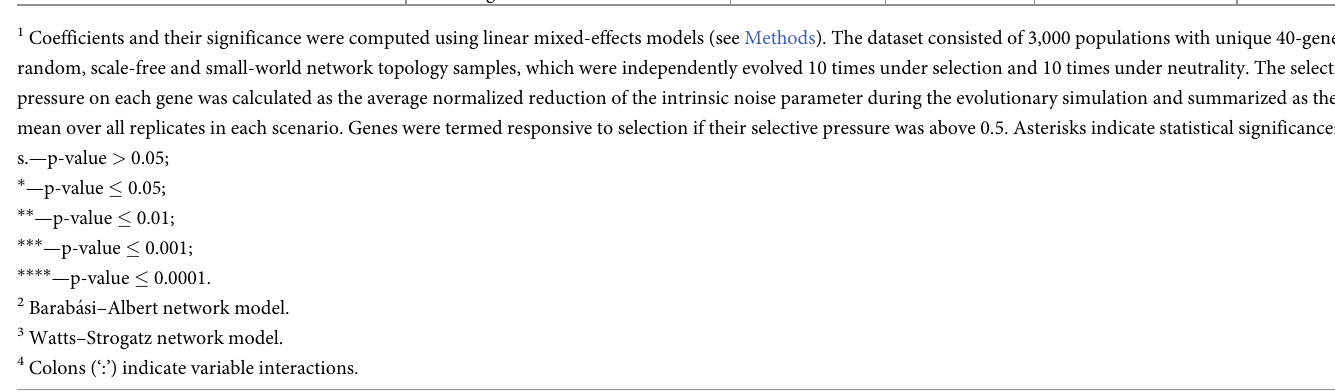
of noise through noise propagation between the genes. Specifically, networks with a lower diameter, mean path distance, indegree centralization, and higher outdegree centralization and average degree, had higher average gene expression variance. In the selected populations, the average selective pressure per network was significantly negatively affected by both syn- thetic network diameter and centralization and the synthetic average degree (linear model with synthetic network diameter and centralization coefficient β = -0.003, p-value = 4.9 × 10 − 11 , Fig 6A; synthetic average degree coefficient β = -0.009, p-value < 2.2 × 10 − 16 , Fig 6B). The mutual information was significant between the average selective pressure per network and synthetic network diameter and centralization (MI = 0.27, p-value � 10 − 4 , permutation test) and synthetic average degree (MI = 0.26, p-value � 10 − 4 , permutation test). This result shows that the average selective pressure acting on gene-specific expression noise in networks decreases with an increase of network diameter, mean path distance, indegree centralization and average degree per network. Conversely, the average selective pressure increases with an increase of outdegree centralization (Fig 6A and 6B). In the populations evolved under neu- trality, neither synthetic network diameter and centralization, nor synthetic average degree,